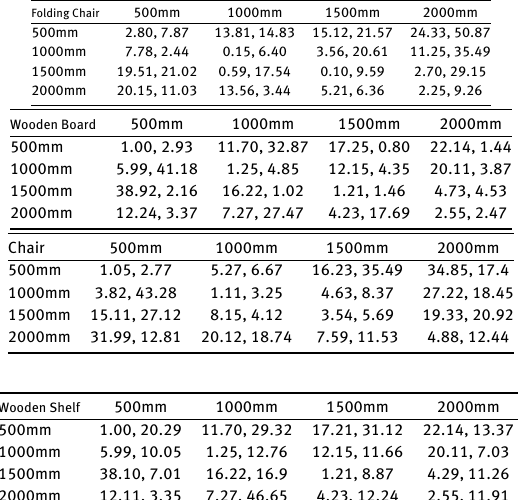
Figure 13: A relationship between a distance and model’s data vol- ume. The volume becomes small when the distance is large.